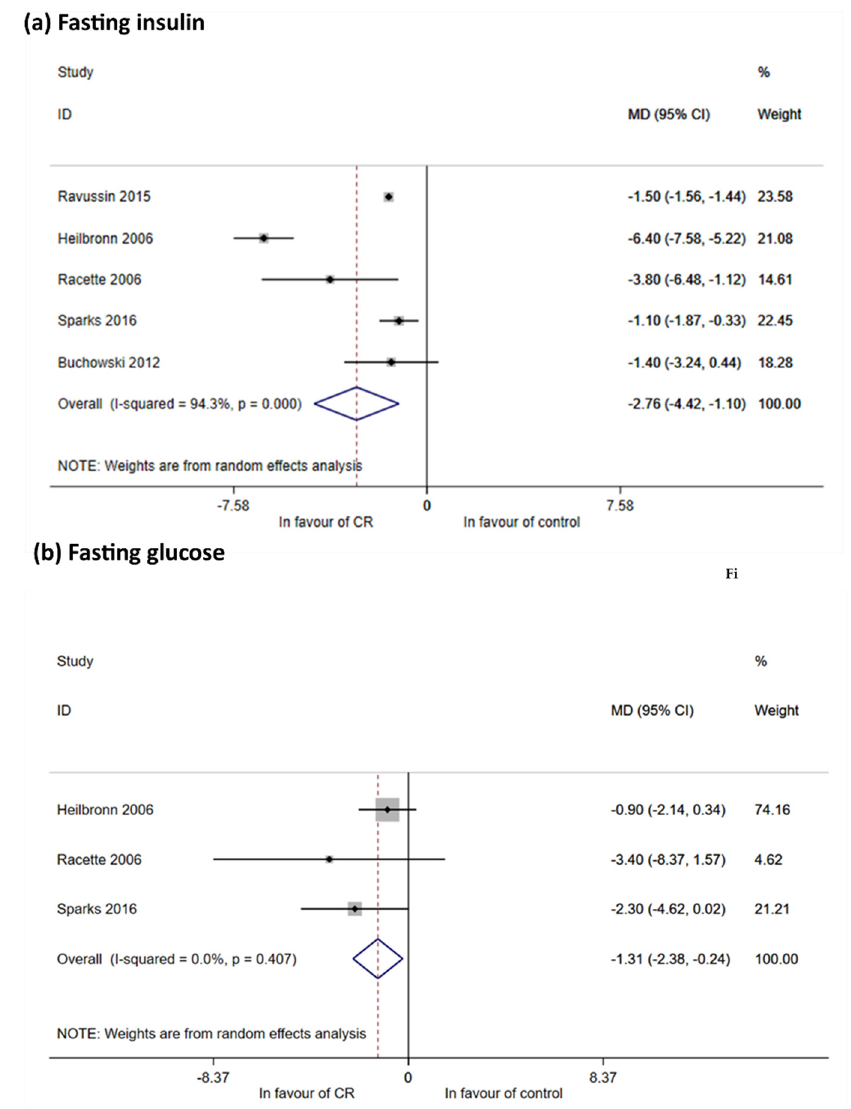
Figure 4. Meta-analysis for fasting glucose and insulin. ( a ) Meta-analysis using random effect method, outcome fasting insulin . Meta-analysis was performed using post mean value (or median value) and